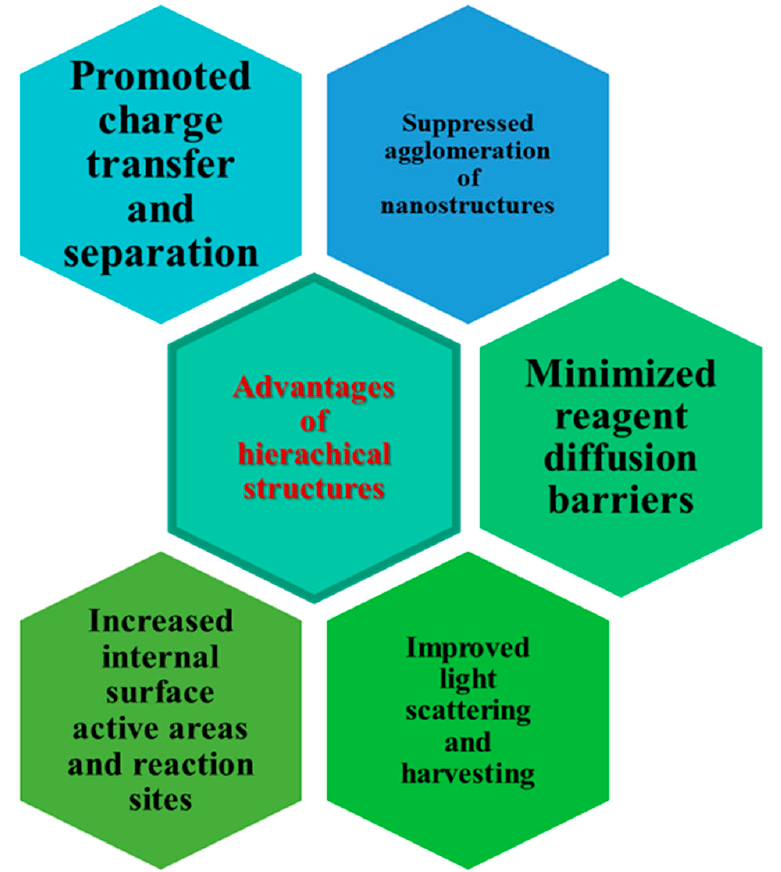
Figure 1. Main advantages of hierarchical porous structures in photocatalysis. Indeed, properly tuning the pore hierarchy can increase the number of light traveling paths within the catalyst, resulting in multiple reflections as in hollow structures or enhanced light scattering phenomena, thus improving the absorption efficiency (Figure 2)